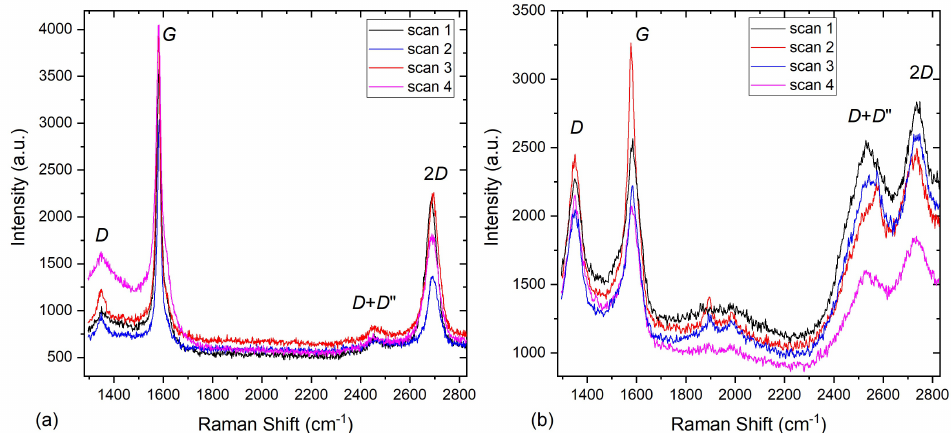
Figure 8. RT Raman spectroscopy measurements for ( a ) the bare graphene sheet on the Si/SiO 2 substrate and ( b ) graphene under the Eu 3 O 4 film after etching the Au capping layer.